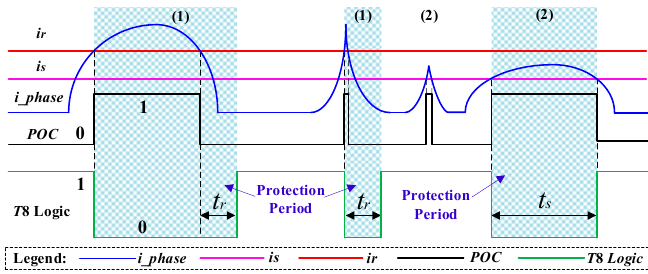
Figure 9. Phase over-current protection logic.